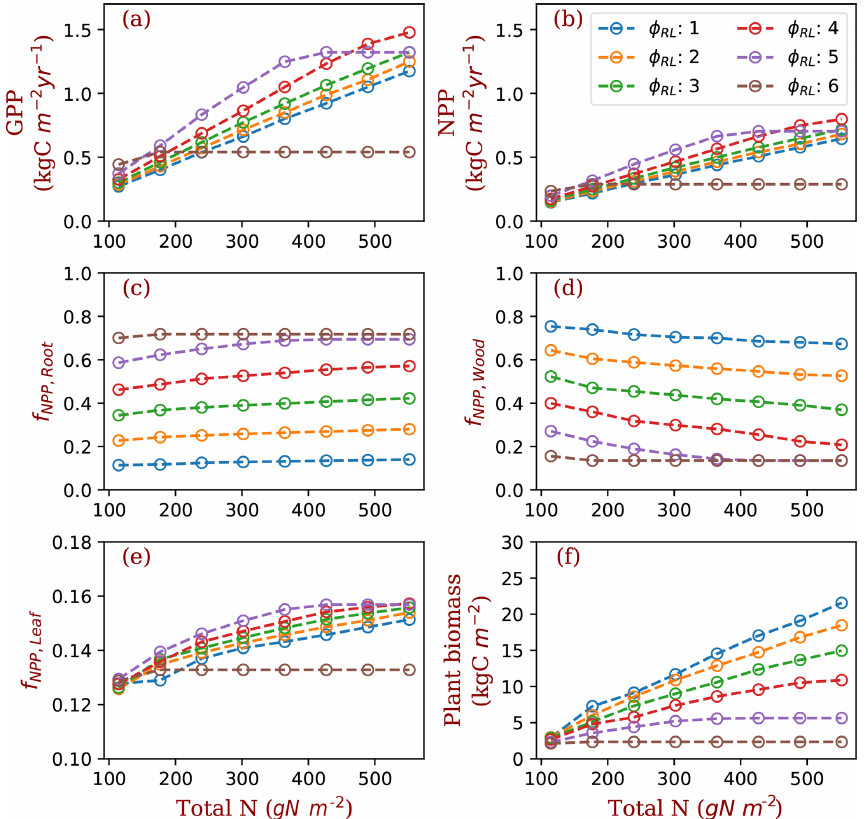
Figure 3. GPP, NPP, allocation and plant biomass at equilibrium state simulated by monoculture runs. GPP: gross primary production; NPP: net primary production; f NPP ,x : the fraction of NPP allocated to x , where x is root (fine roots), leaf (leaves in crown) or wood (including tree trunk, stems and coarse roots). The data are from the averages of the model run years from 1400 and 1800. Each model run is initiated with one PFT with a fixed ratio of fine root area to leaf area ( ϕ RL